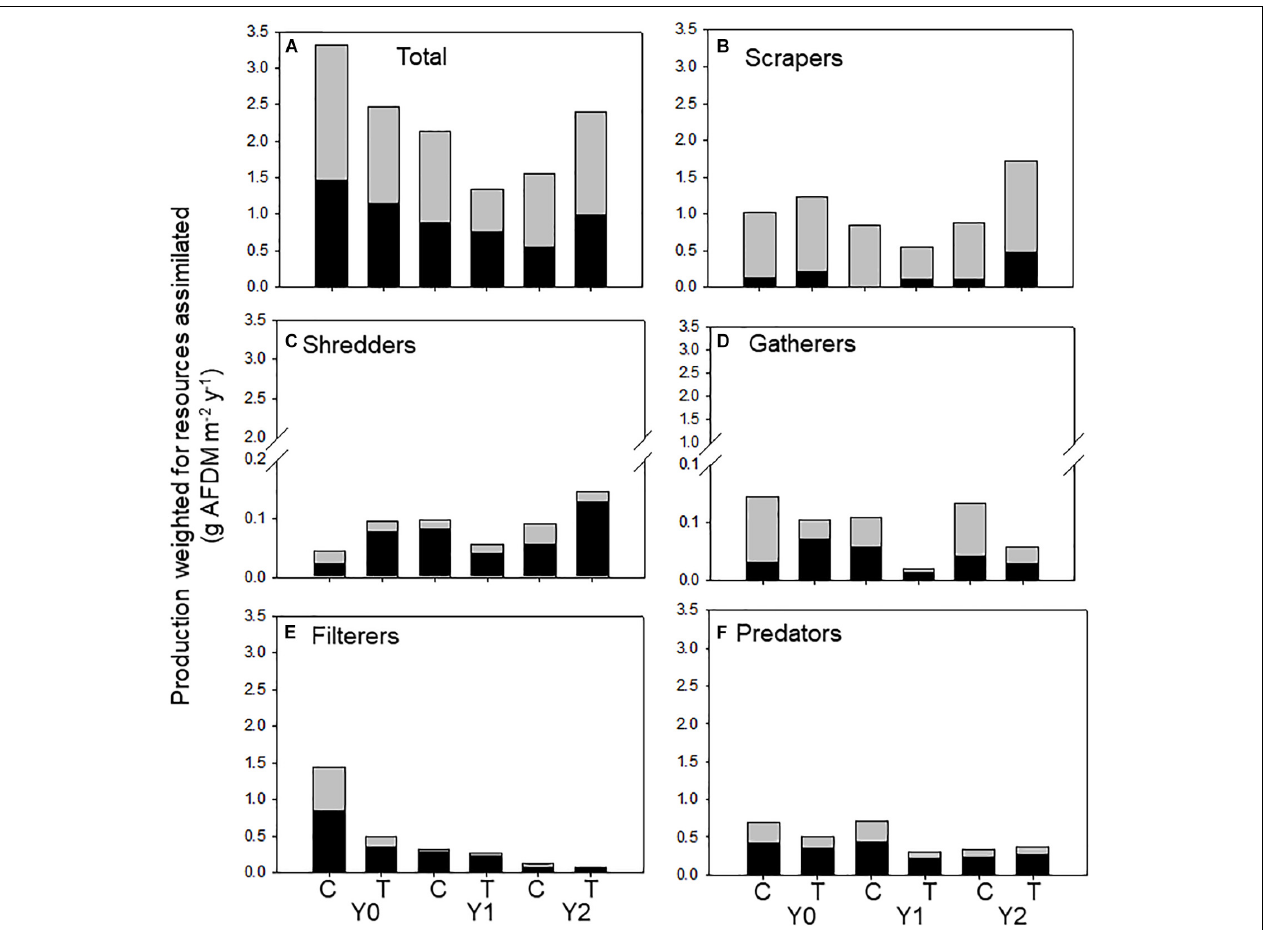
FIGURE 4 | Total macroinvertebrate secondary production supported by allochthonous (dark bars) and autochthonous (light bars) food resources assimilated by macroinvertebrates (categorized by functional feeding groups) in an upstream control C and downstream wood-added reach (treatment, T) 1 year before (Y0) and 1 (Y1) and 2 years (Y2) after wood addition. (A) Is total macroinvertebrate production weighted for resource assimilation, (B) is scraper production weighted for resource assimilation, (C) is shredder production weighted for resource assimilation, (D) is gatherer production weighted for resource assimilation, (E) is filterer production weighted for resource assimilation, and (F) is predator production weighted for resource